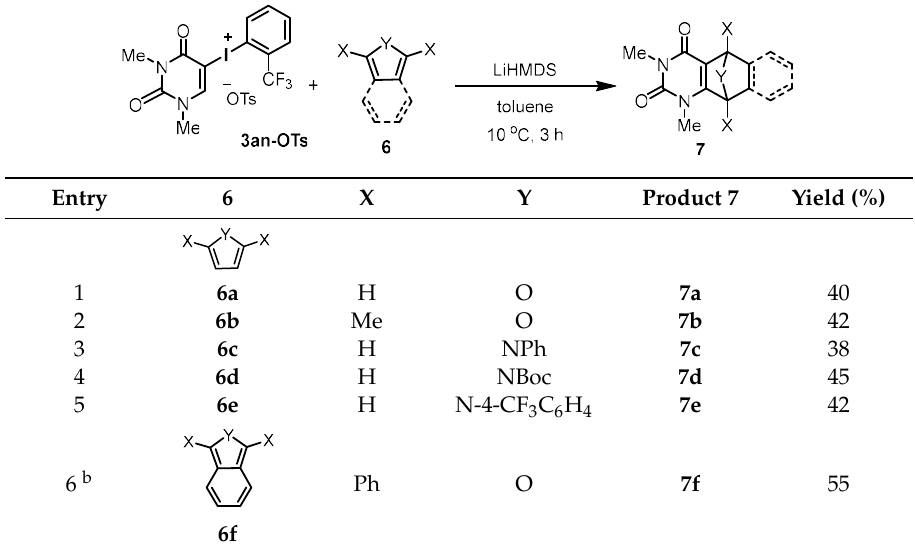
Table 4. [4 + 2] Cycloaddition using uracil-iodonium(III) salt 3an-OTs a .